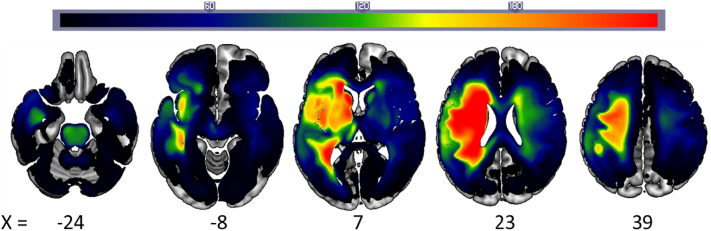
Lesion frequency. Axial slices of a lesion frequency image for 818 patients.